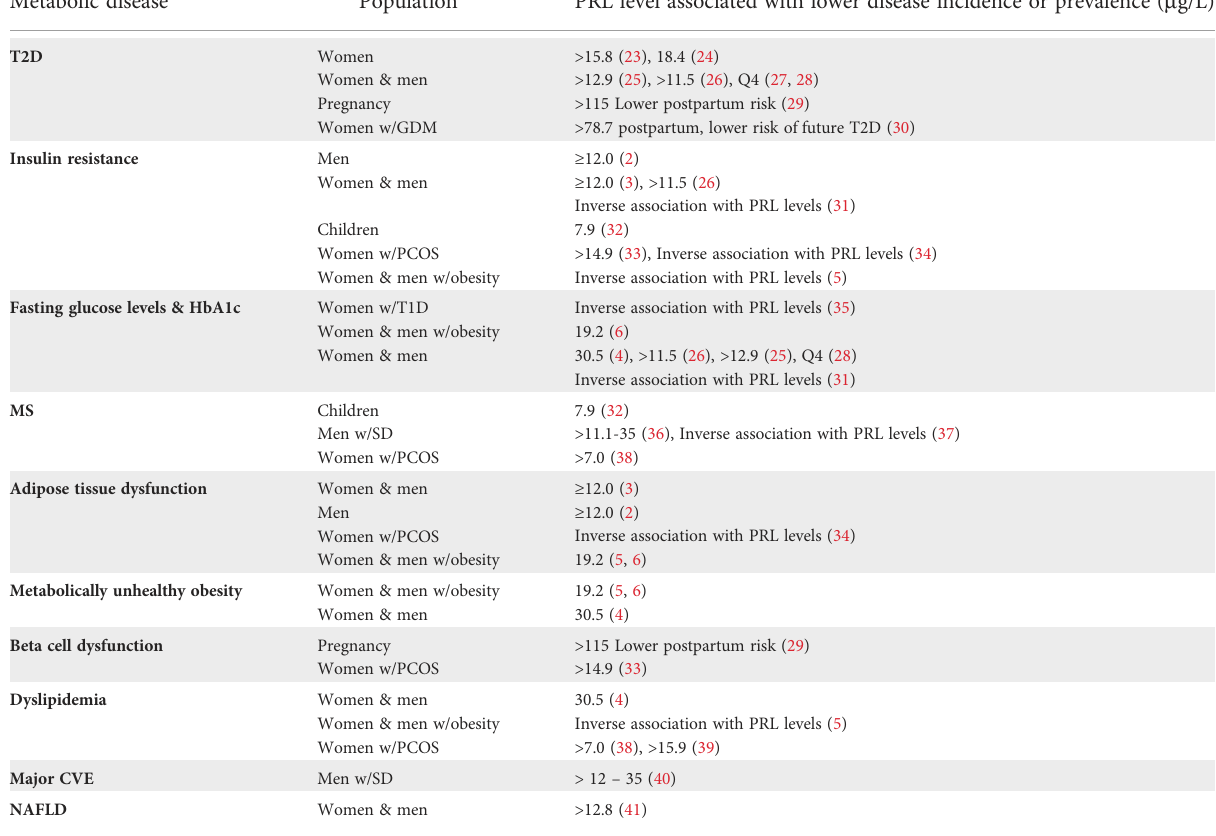
TABLE 1 Moderately high PRL serum levels associate with lower incidence of metabolic disease. Metabolic